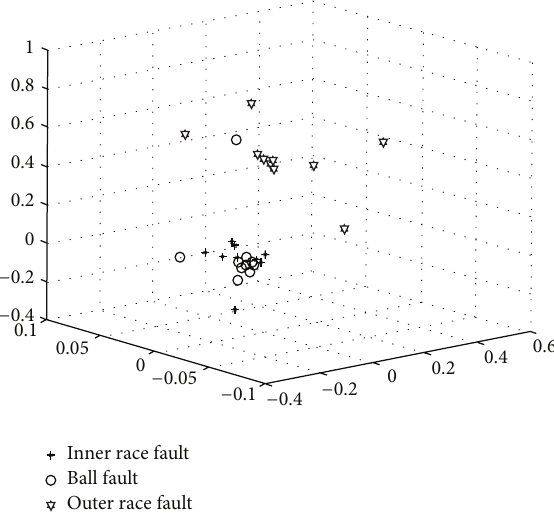
Figure 7: The result of the signal purified by optimized morpholog- ical filter and use of the PCA to extract the original features.